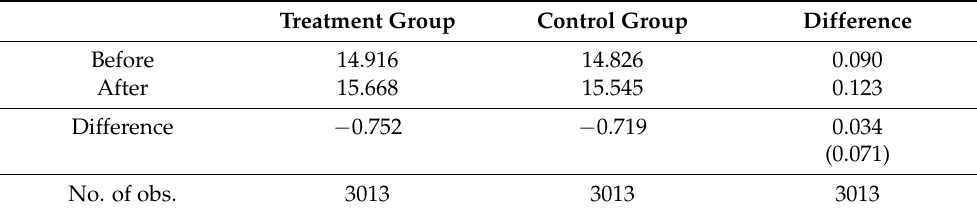
Table 6. The DID estimation of the impact of irrigation on log total